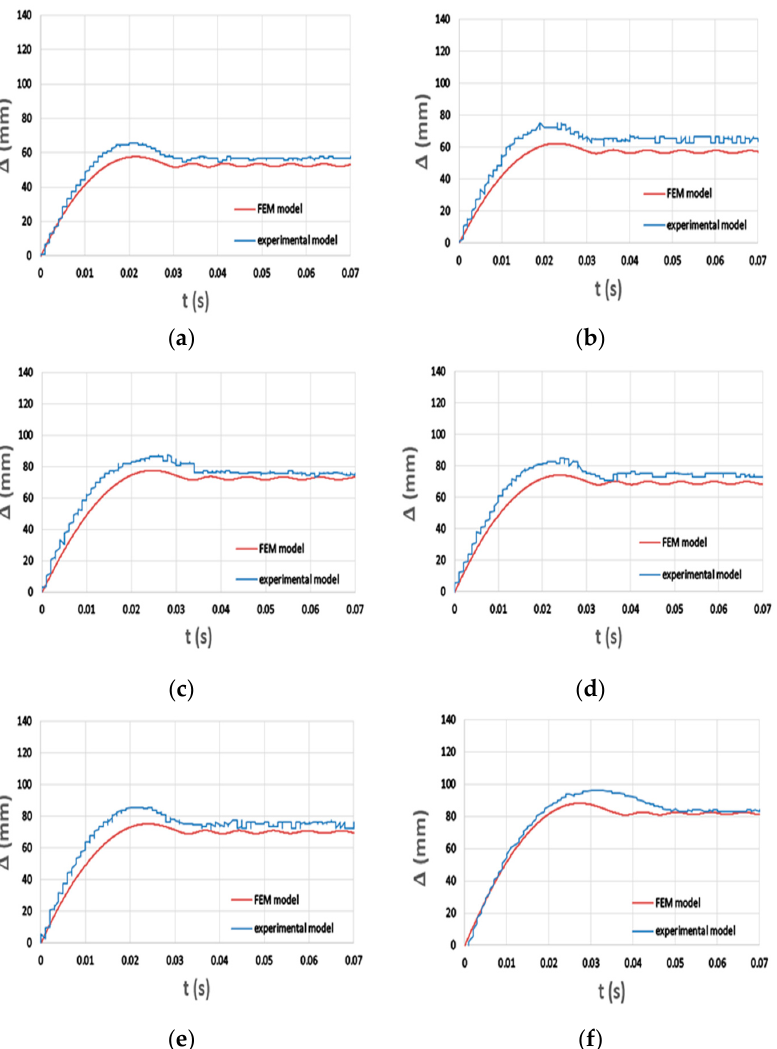
Figure 11. Time history of mid-span deflection: ( a ) NC-M1-H1; ( b ) RUC-M1-H1; ( c ) RUC-M1-H2; ( d ) SFC-M1-H2; ( e ) MC-M1-H2; ( f ) SFC-M2-H2.